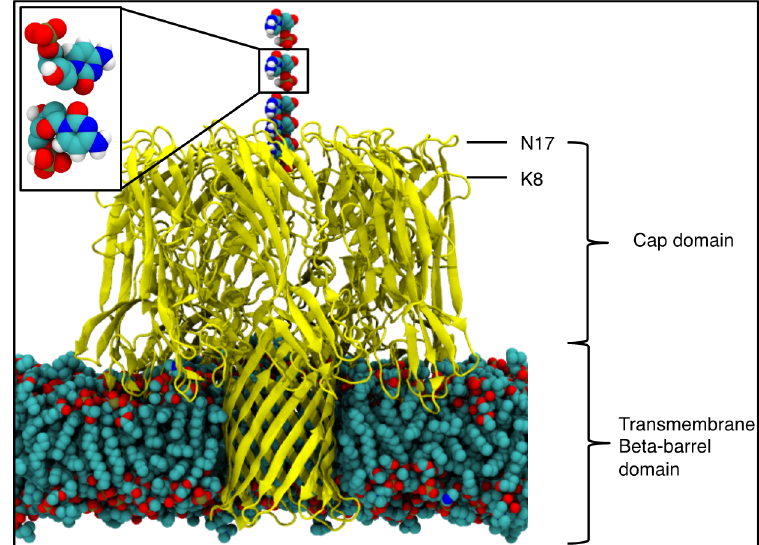
Figure 1. The alpha-hemolysin ( α HL) protein in a 1,2-dimyristoyl-sn-glycero-3-phosphocholine (DMPC) bilayer, with the mononucleotide positioned above the vestibule entrance, where each mononucleotide represents an individual simulation. The protein is represented by yellow ribbons and for other atoms: Carbon is shown in cyan, oxygen in red, nitrogen in blue, phosphorus in brown and hydrogen in white. The waters and ions are excluded for clarity. ( Inset ) The phosphate orientations used, termed the “up” and “down” orientations, shown top and bottom